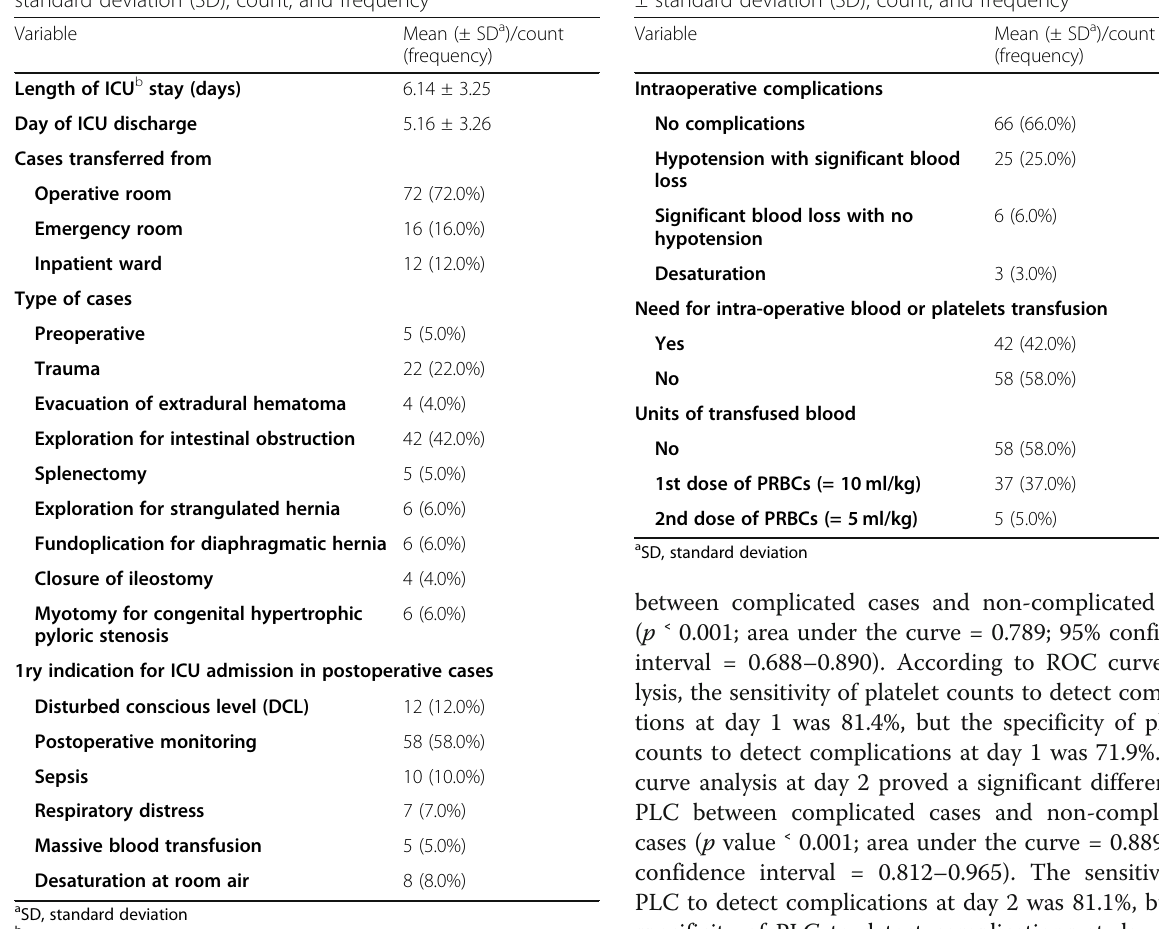
Table 2 Patients ’ characteristic. Data presented as mean ± standard deviation (SD), count, and frequency